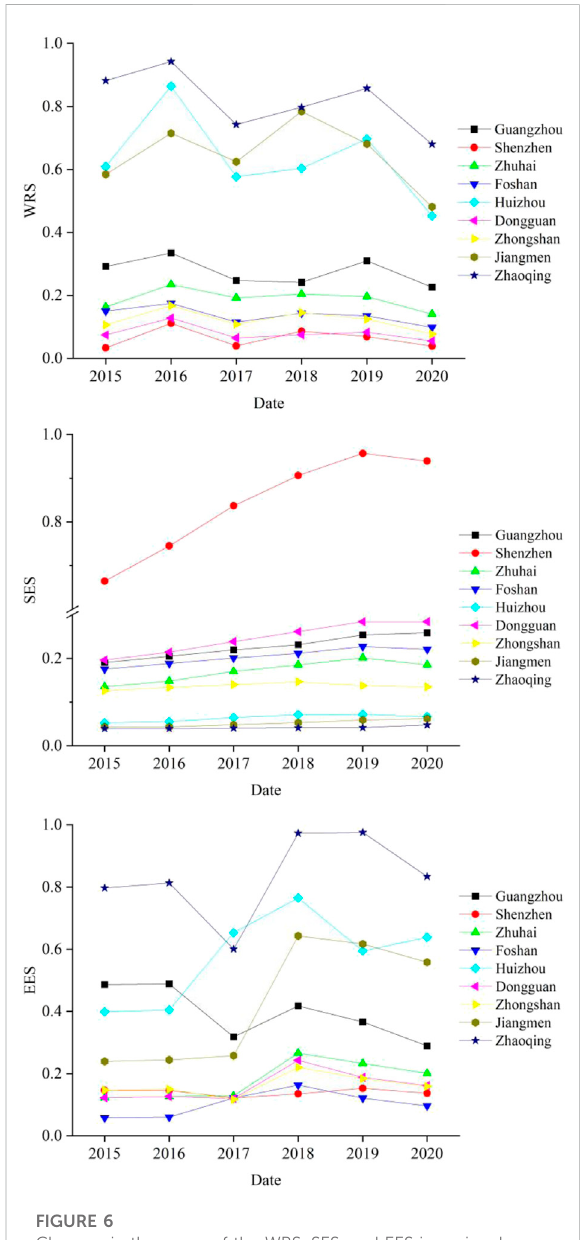
FIGURE 6 Changes in the score of the WRS, SES, and EES in regional WRCC evaluation of cities in PRD from 2015 to